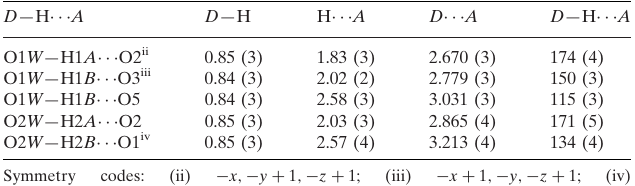
Hydrogen-bond geometry (A˚ , (cid:3) ). D —H (cid:2)(cid:2)(cid:2) A